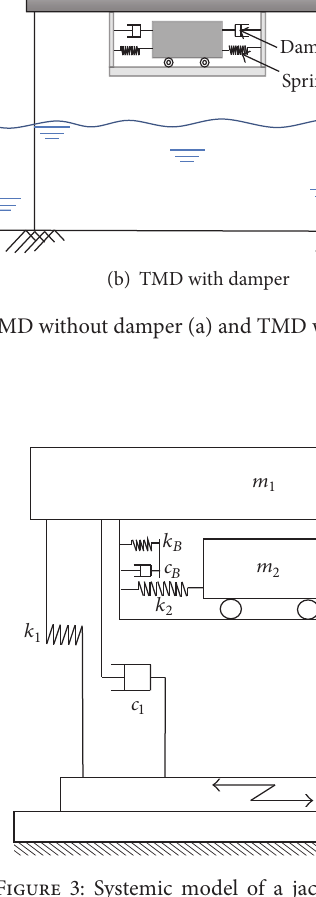
Figure 3: Systemic model of a jack-up offshore platform with a bufferable